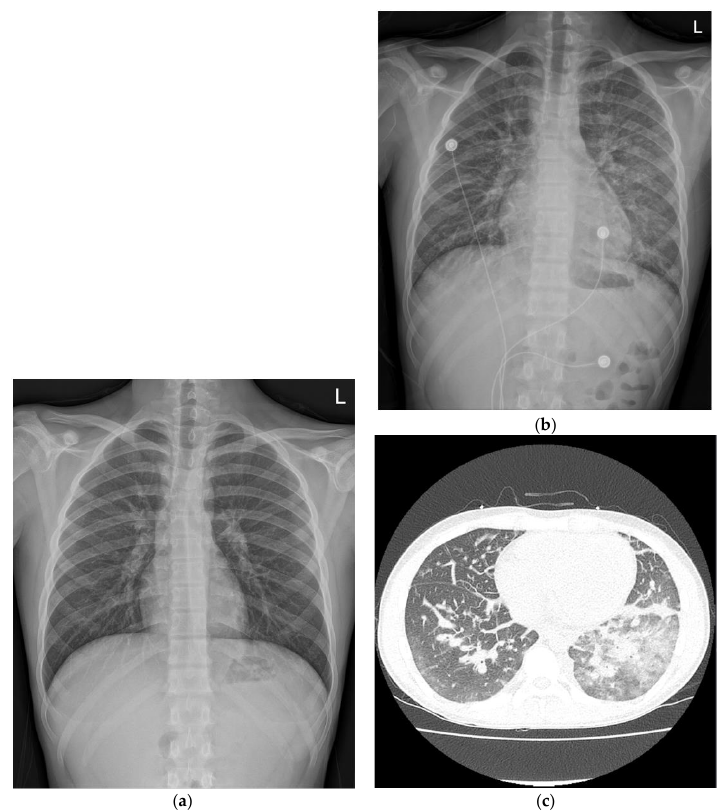
Figure 1. Compared with the chest radiography ( a ) at the time of admission, the chest radiography ( b ) and low-dose chest computed tomography ( c ) performed on the second day of hospitalization revealed pulmonary edema and cardiomegaly findings ( b ) .